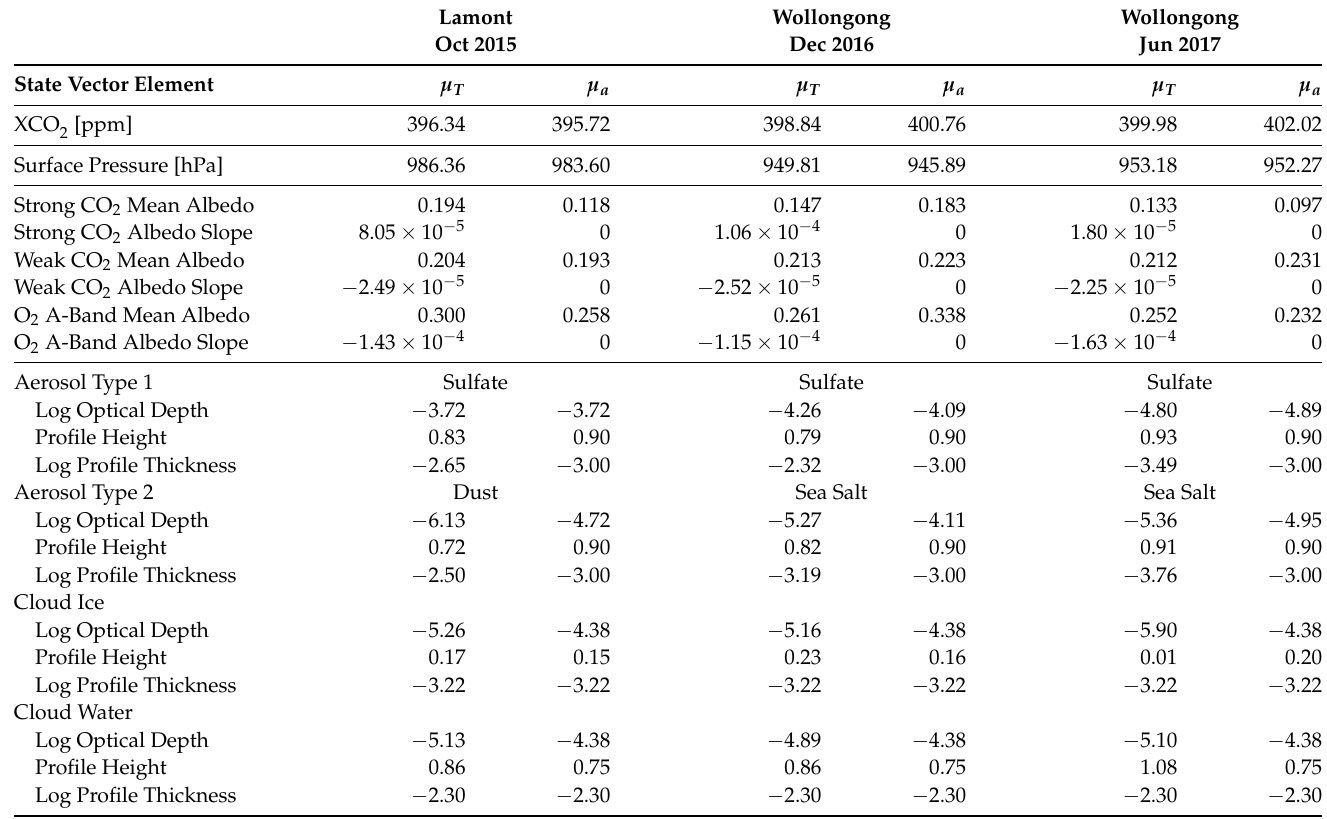
Figure 3. True mean vectors µ T and operational retrieval prior mean vectors µ a for the CO profile at the three TCCON templates. Table 2. True mean vectors µ T and operational retrieval prior mean vectors µ a for selected state vector elements at the three TCCON templates. The CO profile means are displayed in Figure 3. Aerosols are represented with two location-specific 2 types plus cloud ice and